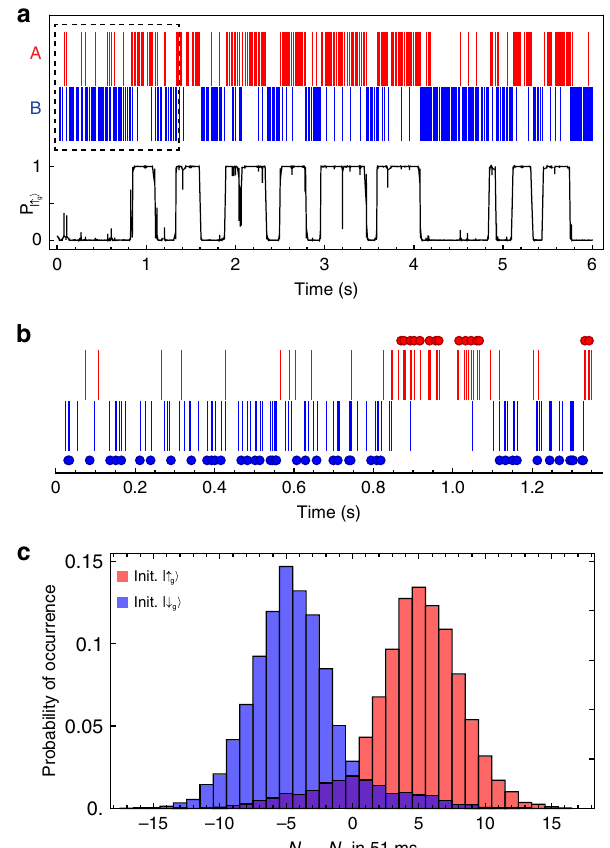
Fig. 3 Quantum nondemolition spin measurement. a Photons detected during a single run of the experiment using the sequence in Fig. 2a. The i inferred from a Bayesian black curve shows the probability to be in j" g analysis, revealing quantum jumps between the spin states induced by optical pumping. b An adaptive maximum likelihood (ML) algorithm is used to perform successive single-shot spin measurements, with the result of each, independent measurement indicated by a circle [data from dashed box in a ]. c Histogram of photon counts for a fi xed integration window of 51 ms following initialization using a ML measurement. The horizontal axis is the difference between the number of A and B photons detected in the measurement